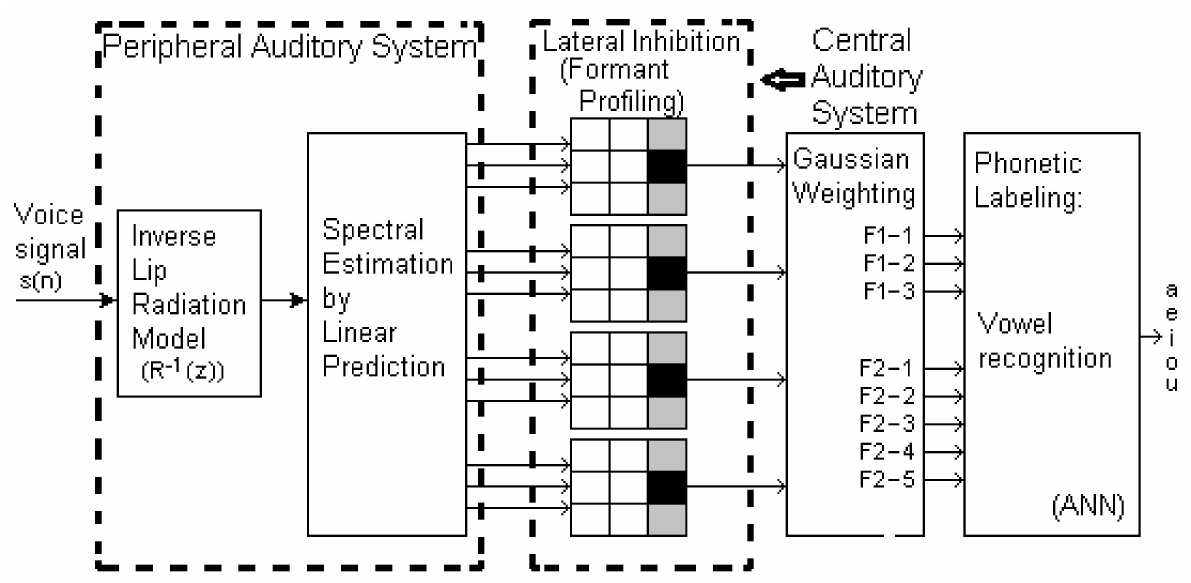
Figure 1. Bioinspired auditory system